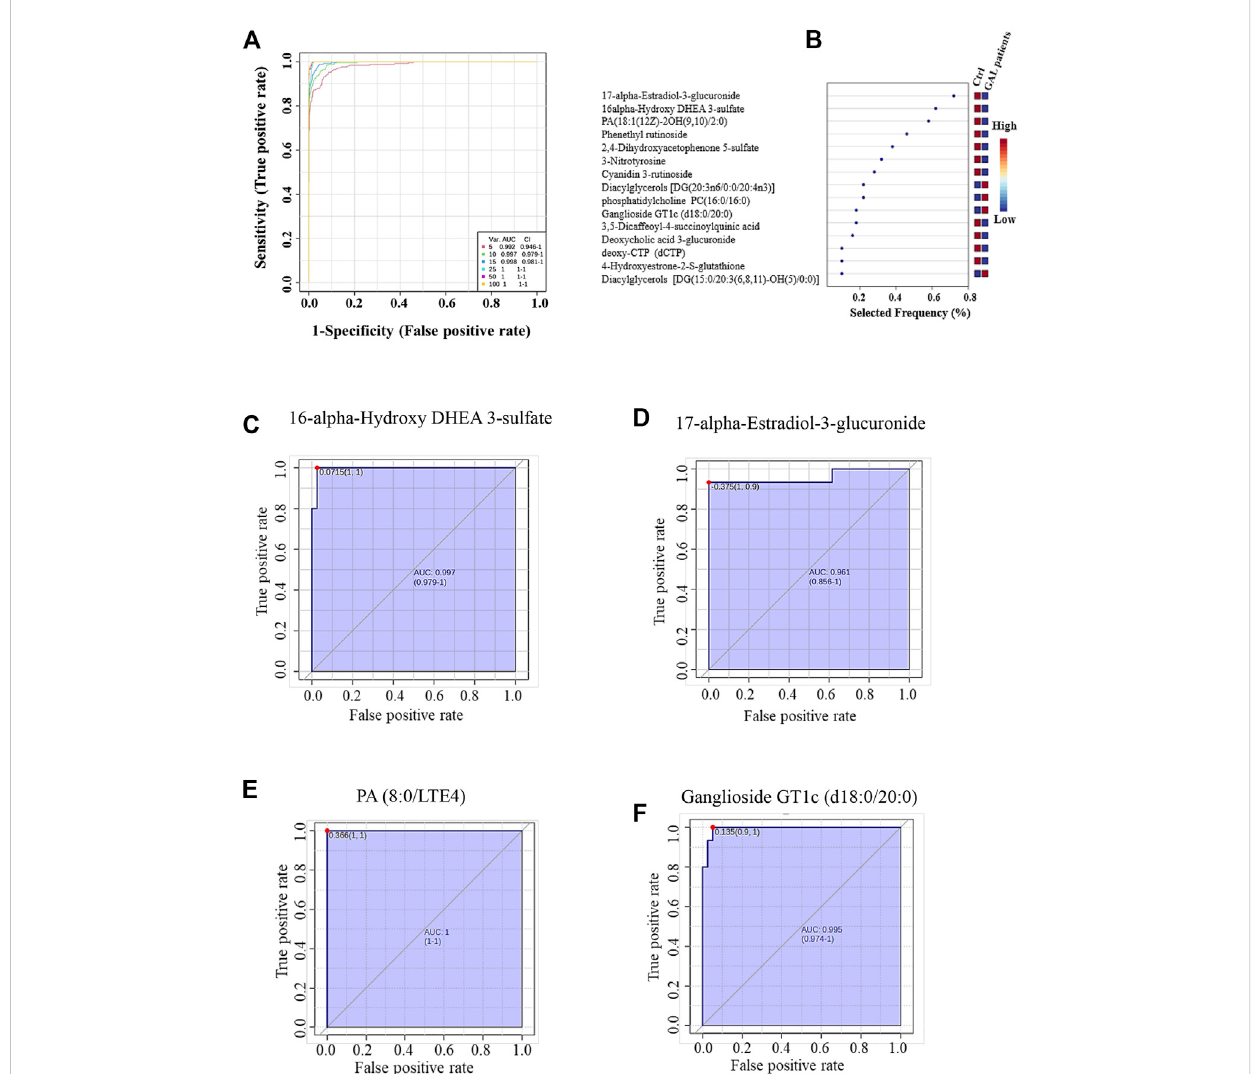
FIGURE 4 (A) The Receiver Operating Characteristics (ROC) curve was generated by the OPLS-DA model, with Area Under the Curve (AUC) values calculated from the combination of 5, 10, 15, 25, 50, and 100 metabolites. (B) The frequency plot shows the signi fi cantly dysregulated endogenous metabolites between the study groups. Representatives downregulated metabolites with their ROC curves are demonstrated for 16-alpha-hydroxy DHEA 3- sulfatediphosphate (AUC (0.997) (C) and 17-alpha-estradiol-3-glucuronide AUC (0.961) (D) in GAL patients. Furthermore, PA (8:0/LTE4) AUC (1) (E) and ganglioside GT1c (d18:0/20:0) AUC (0.995) (F) as examples of upregulated metabolites in GAL